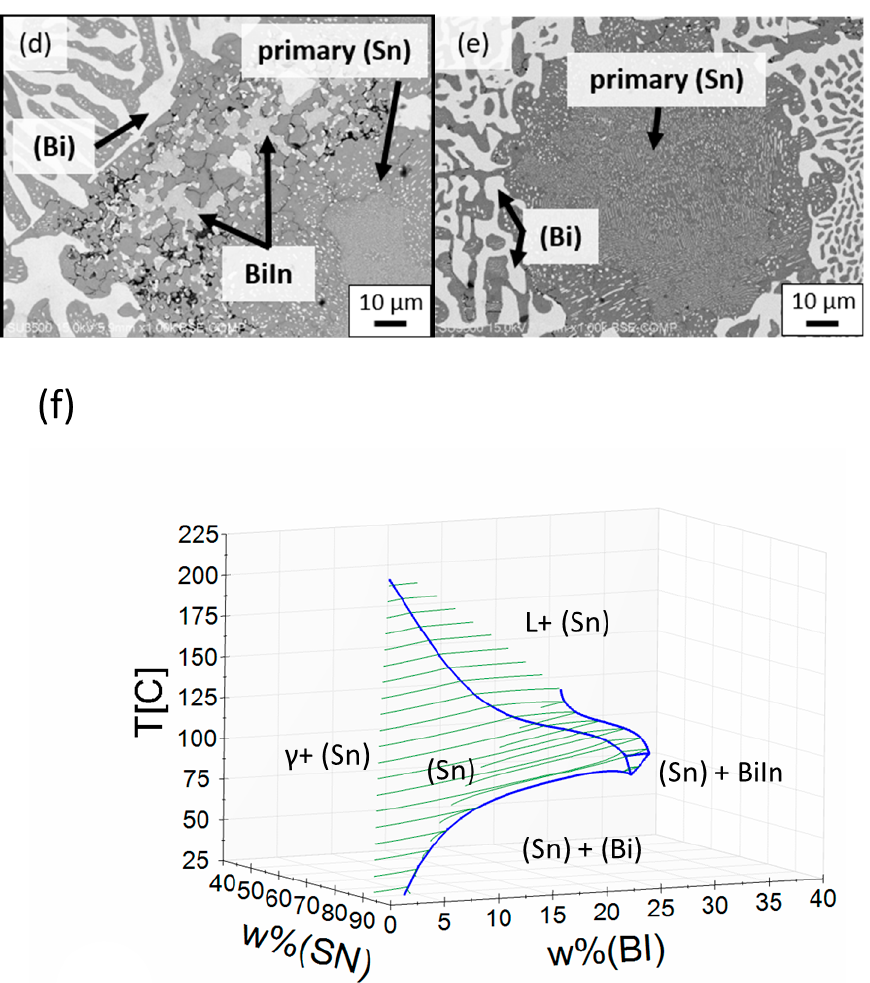
Figure 5. ( a ) The SEM images of the “step-quenched” SBIG alloy. The close-ups at the ( b ) coarse eutectic, ( c ) fine eutectic, ( d ) BiIn IMC, and ( e ) primary (Sn) phase regions. ( f ) The three-dimensional (3D) space diagram of the single (Sn) phase region in the Sn-Bi-In ternary system.